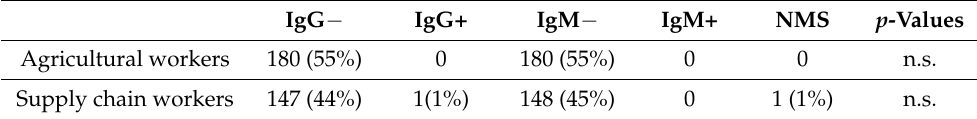
Table 4. Immune status between the two groups of workers toward SARS-CoV-2. IgG − IgG+ IgM − IgM+ NMS p -Values Agricultural workers 180 (55%) 0 180 (55%) 0 0 n.s. Supply chain workers 147 (44%) 1(1%) 148 (45%) 0 1 (1%)